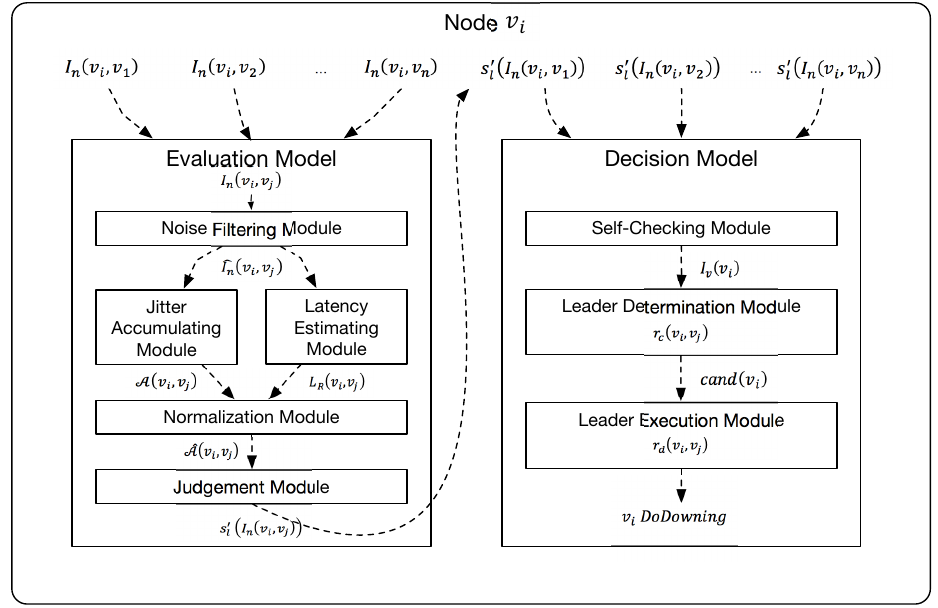
Figure 2. Algorithm